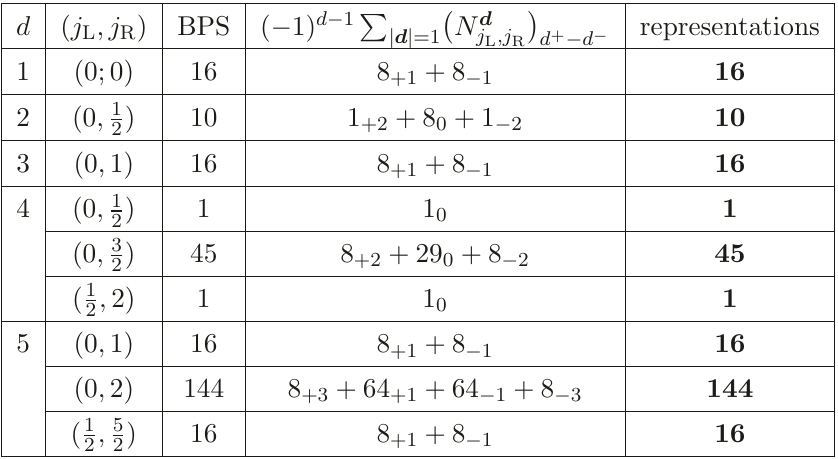
Table 1 . The BPS indices N d for 1 ≤ d ≤ 5 of the (2 , 2) model with the rank j L ,j R